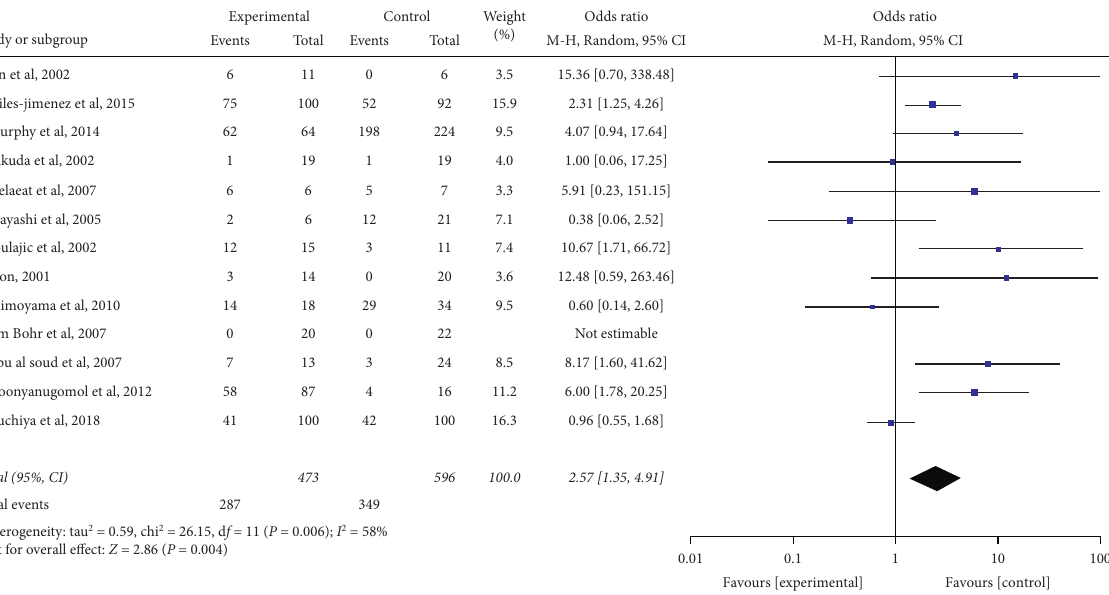
Figure 2: Forest plot for the pooled odd ratio and 95% confidence interval.